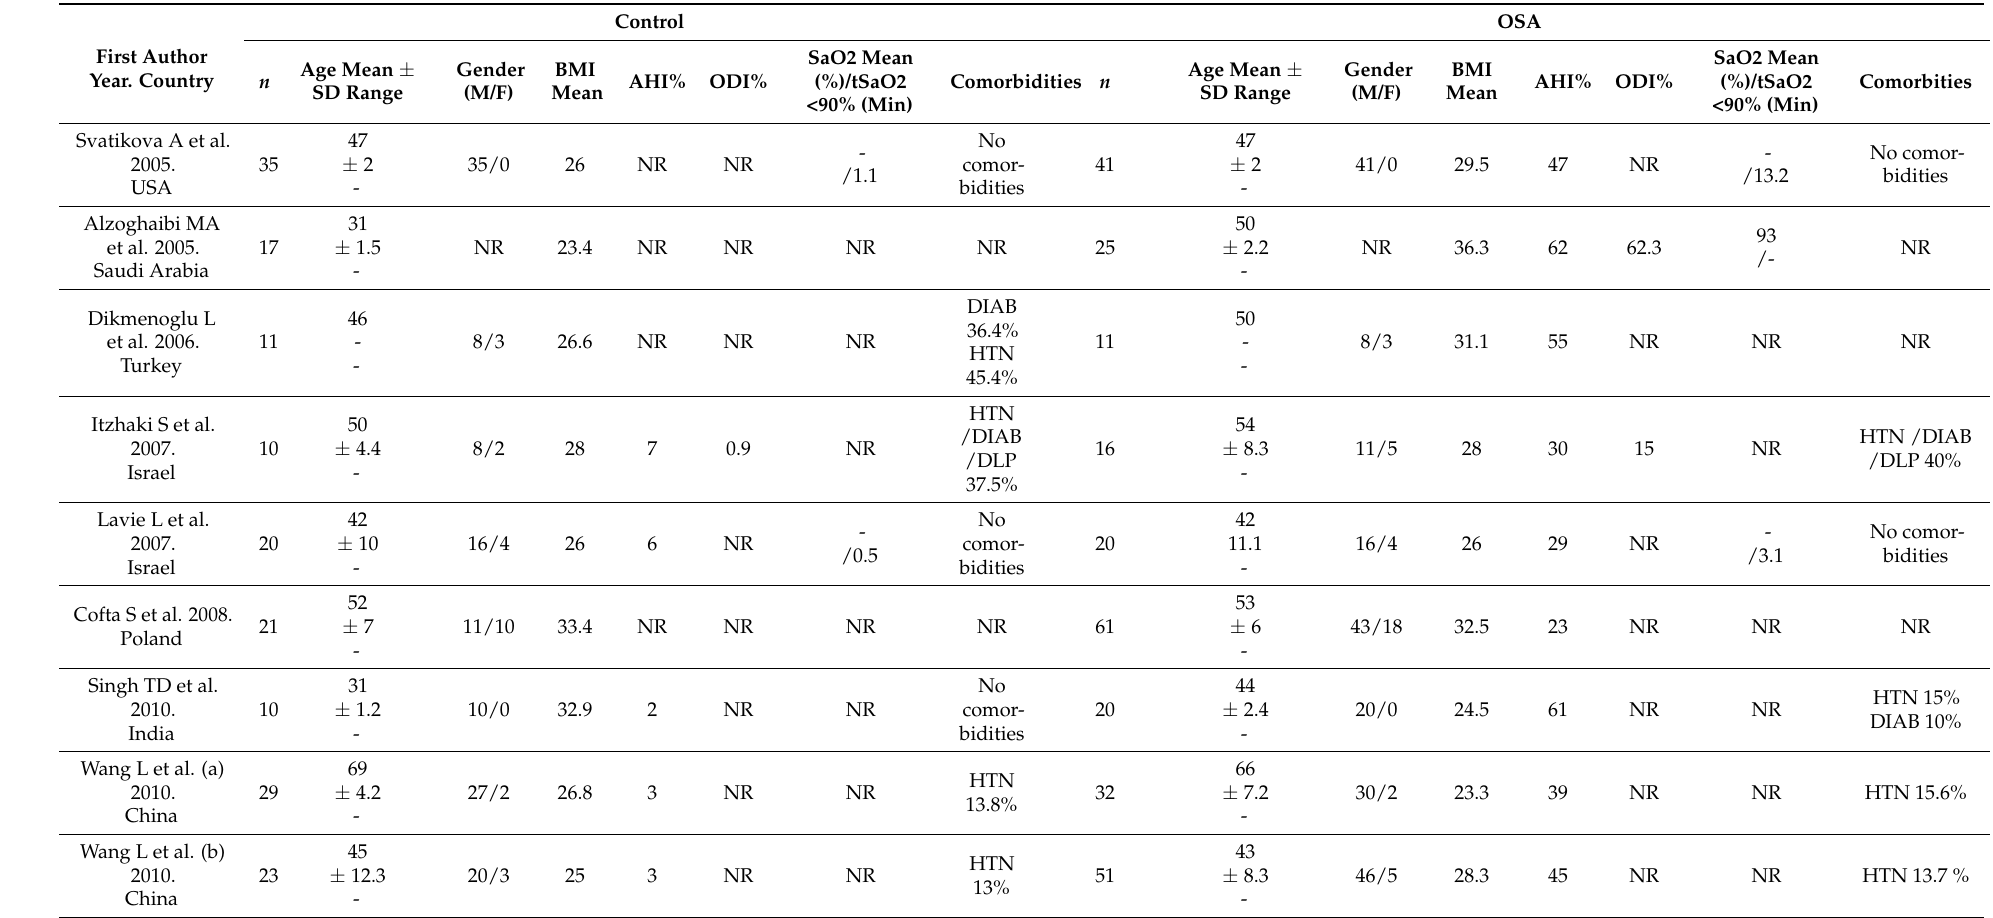
Table 1. Participant characteristics of the studies included in the